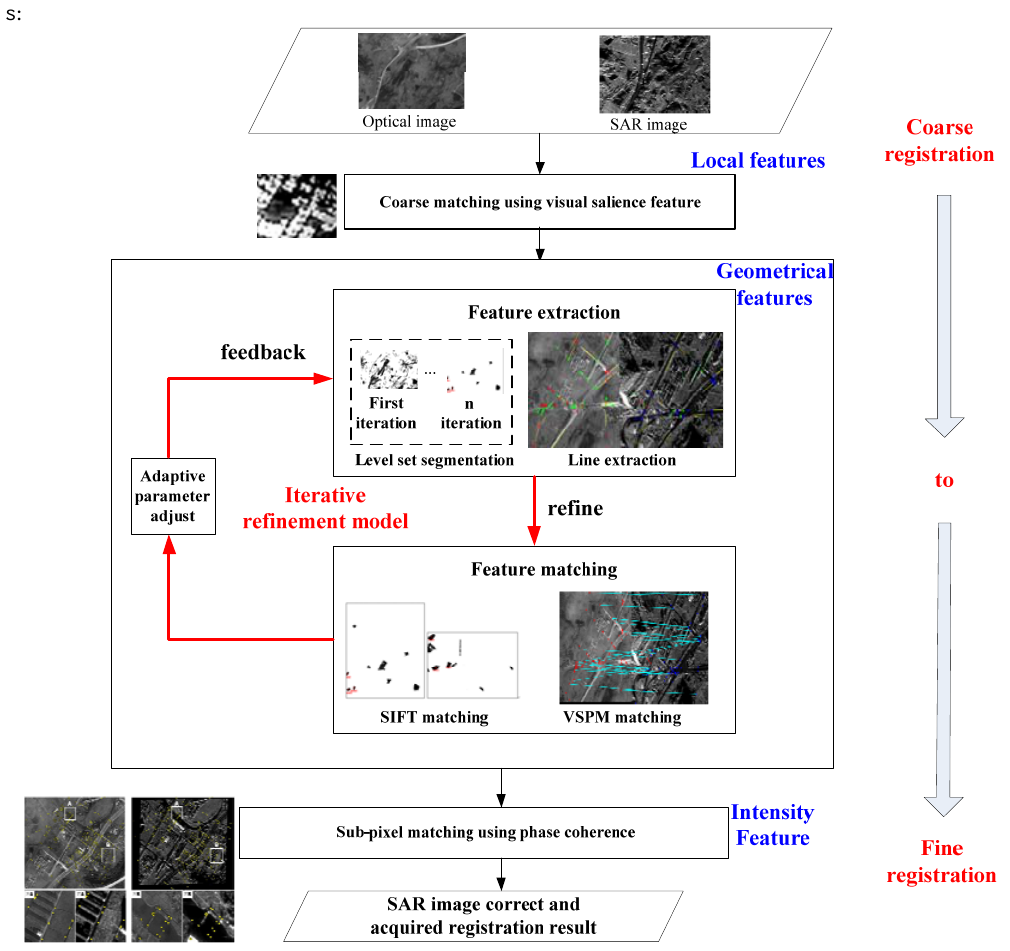
Figure 1. The basic principle of the proposed method